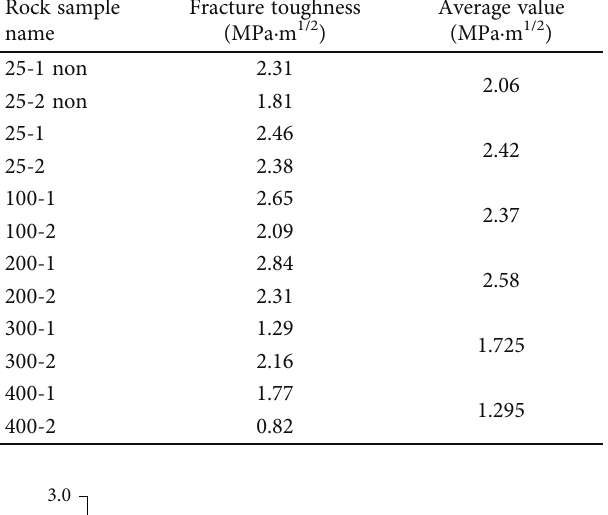
Table 5: The fracture toughness of di ff erent samples. Rock sample